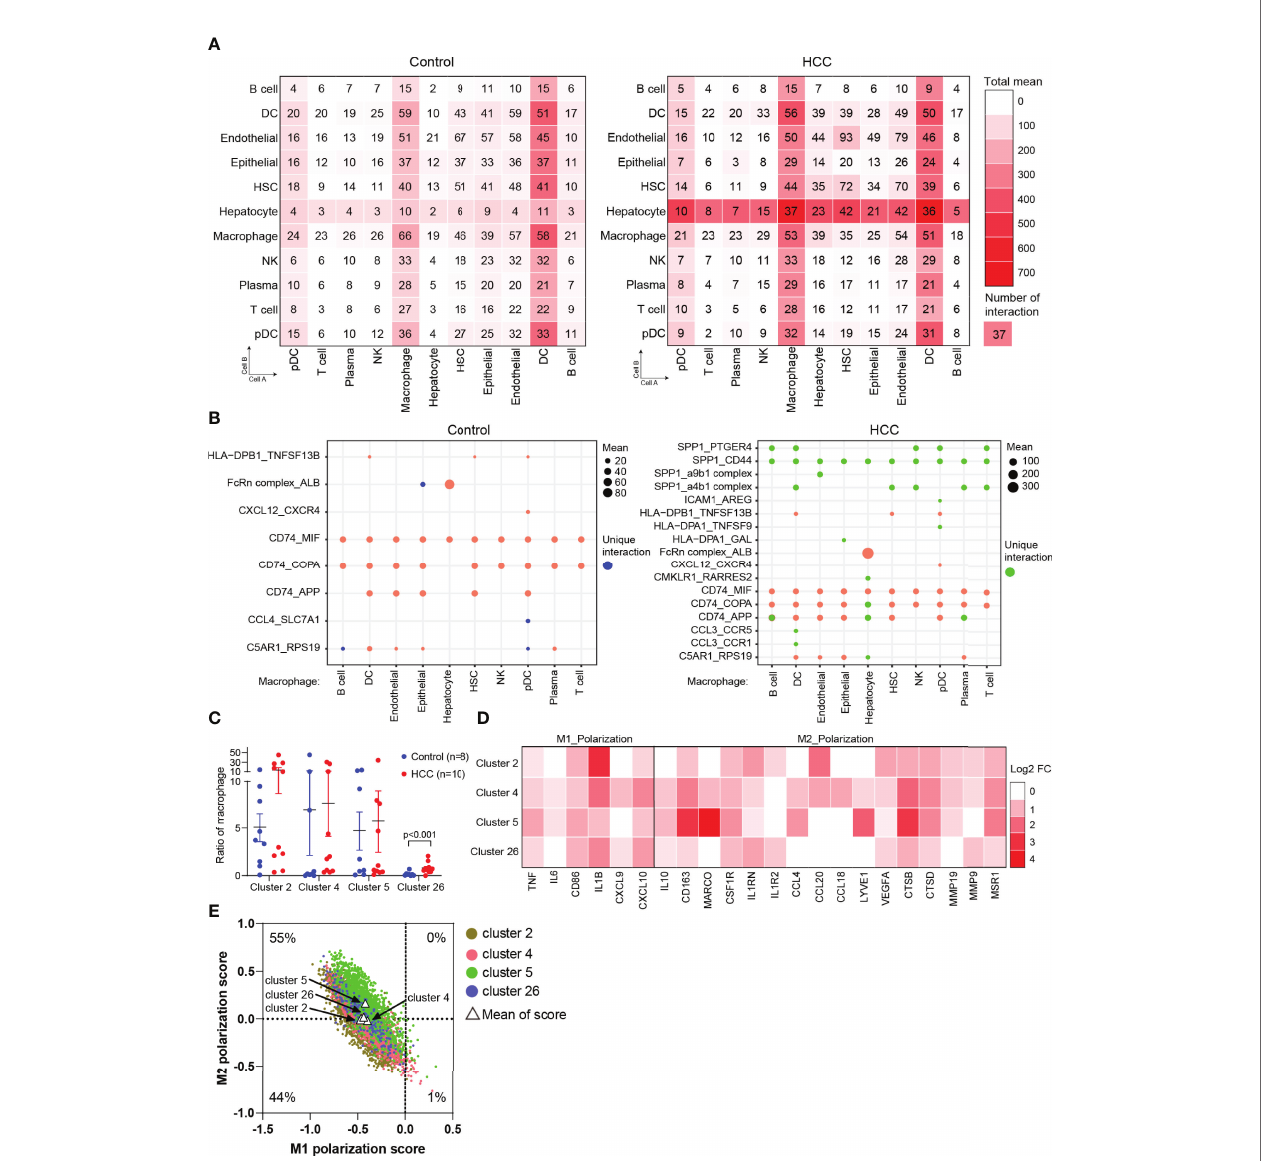
FIGURE 3 | Cell crosstalk in HCC. (A) The strength of cell crosstalk shown as total mean and number of interactions. (B) Cell crosstalk based on ligand – receptor interaction in the non-tumor and tumor tissues (signi fi cant mean >10). (C) Ratio of macrophages of clusters 2, 4, 5, and 26 in the individuals. (D) The phenotype of macrophages in HCC. (E) Scatterplots showing M1 and M2 scores for each color-coded cluster of macrophages. HCC, hepatocellular